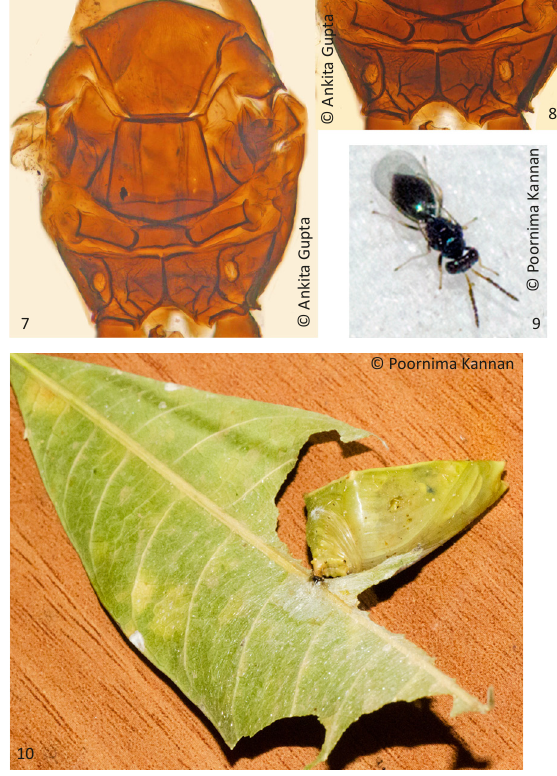
Images 7−10. Tetrastichus bilgiricus female 7 - Mesosoma (KOH treated); 8 - Propodeum; 9- Habitus; 10 - Host-parasitised pupa of Euthalia aconthea meridionalis.